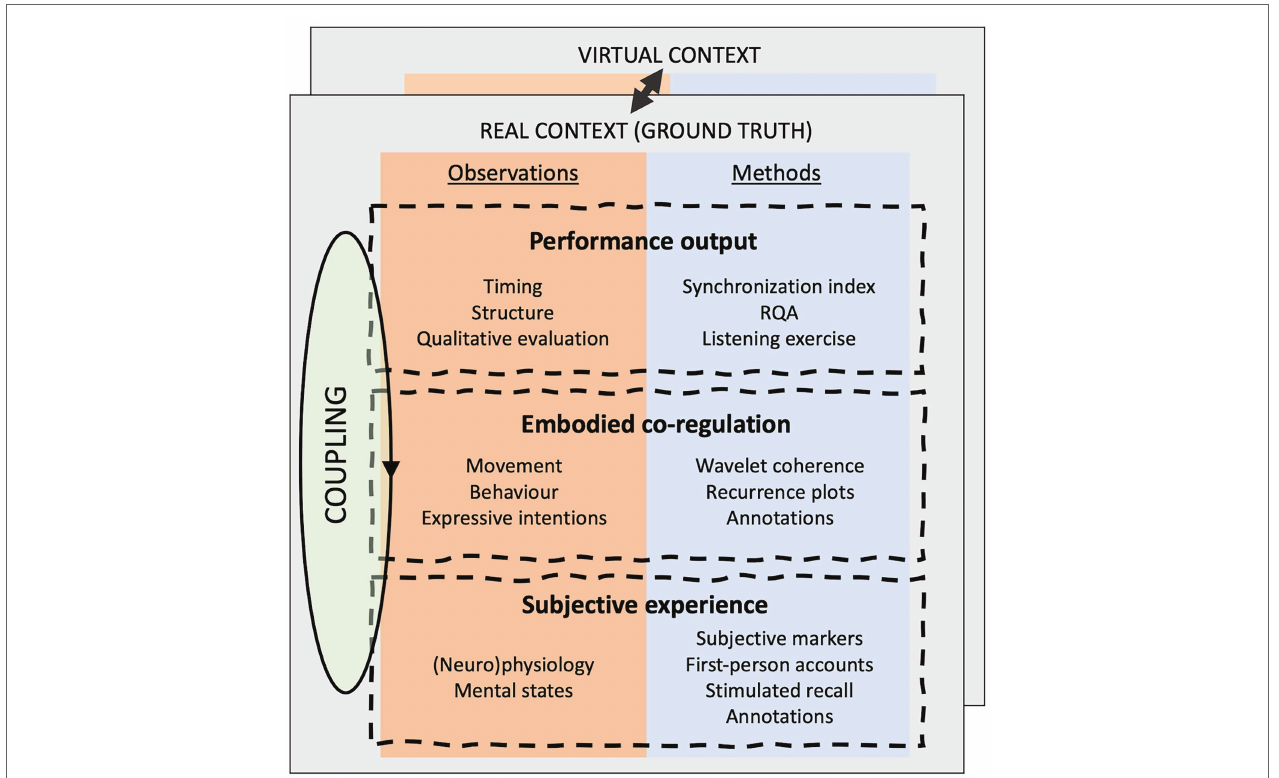
FIGURE 1 | Overview of the methodological framework to operationalize social presence in virtual reality (VR) music contexts. The core of the framework consists of a comparative analysis of a simulated virtual context, with the corresponding real-life music context (which functions as “ground truth”) across three interrelated layers; performance output, embodied co-regulation, and subjective experience. (RQA, recurrence quantification